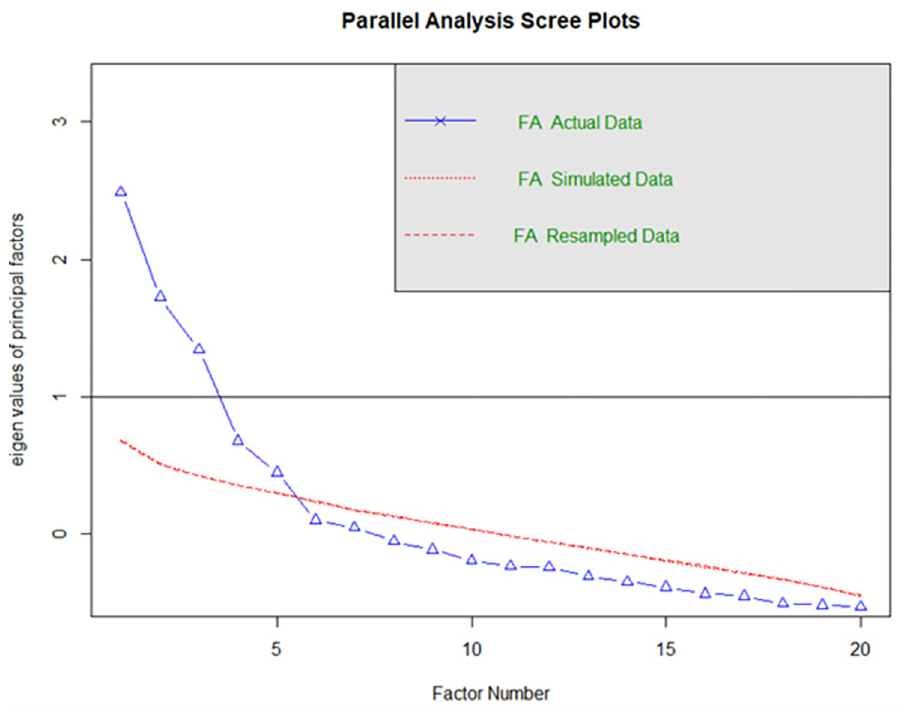
Fig 1. Study 1 scree plot on the entire